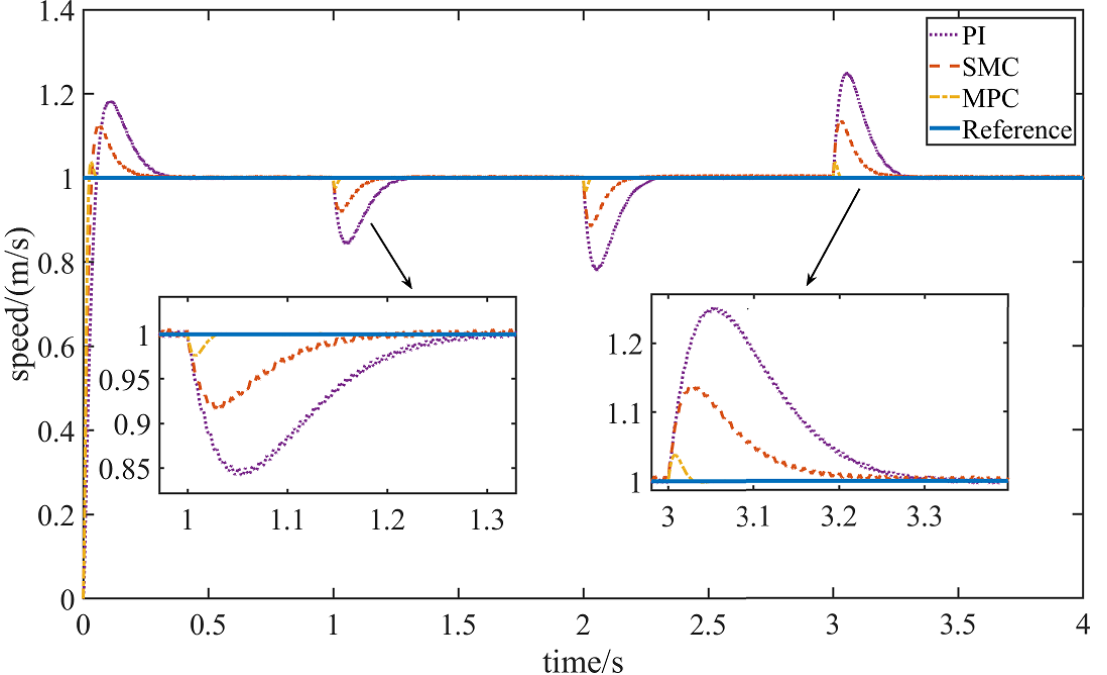
Figure 8. Comparison of operating speeds under variable loads.